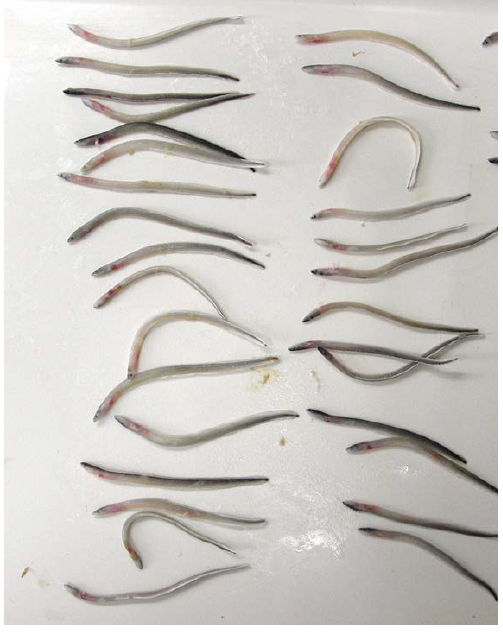
Figure 1. Haemorrhages on the skin of European glass eel.